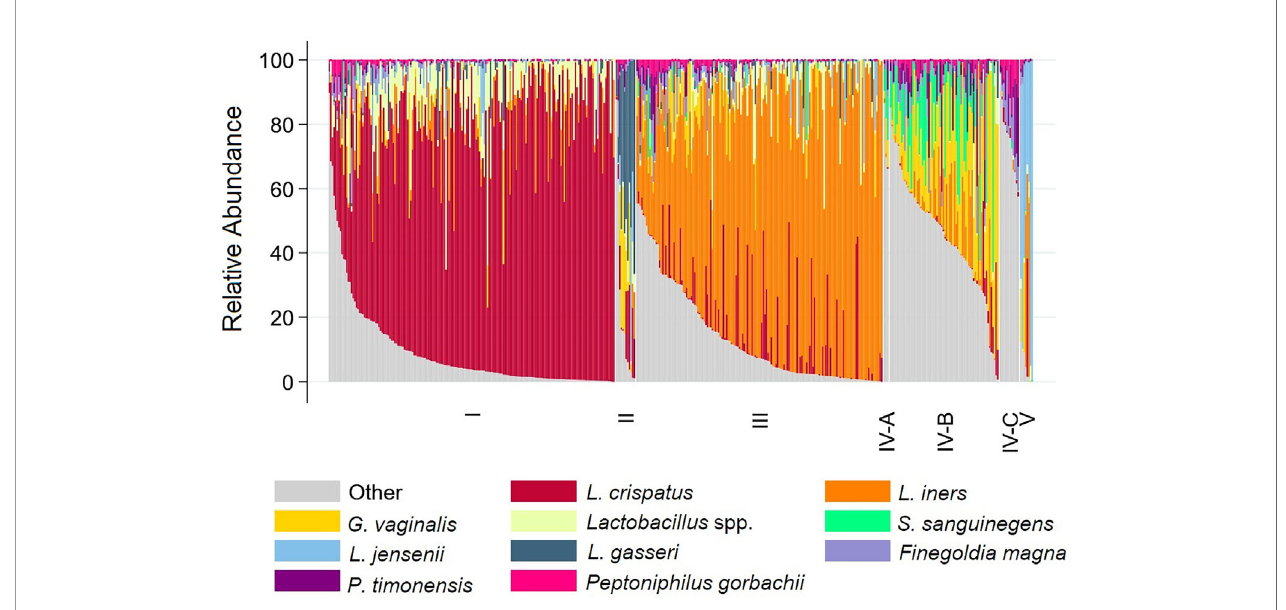
FIGURE 1 | Stacked bar chart showing relative abundance of 10 taxa with highest mean relative abundance by community state type for each participant. Legend: The relative abundance of the 10 taxa with the highest mean relative abundance is shown (y-axis), with individual subjects represented by individual bars (N=431), separated by Community State Type (x-axis).